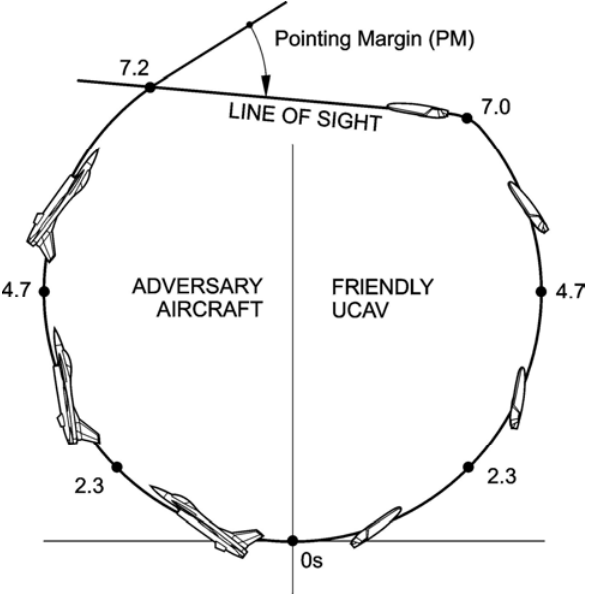
Fig 3. Pointing Margin (PM) is used to assess combat agility, see also